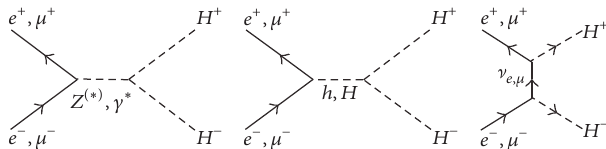
Figure 4: The possible Feynman diagrams for double Higgs production at lepton colliders.